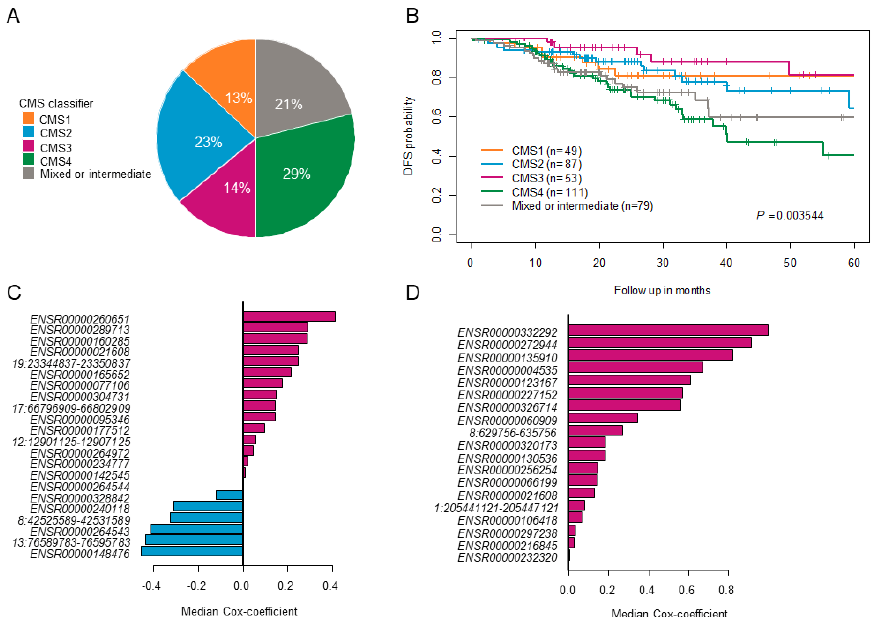
Figure 2. Identification of clinically relevant enhancer RNAs. ( A ) Pie-chart shows the percentage of colon cancer patients classified into various consensus molecular subtypes (CMS). ( B ) Kaplan–Meier plot shows survival estimates of disease-free survival in colon cancer patients stratified based on the CMS classification. ( C , D ) The bar graph shows prognostic eRNAs from the successful trials that significantly separated samples into two risk groups in the testing set and are ordered by their median cox-coefficient for disease-free survival. Positive scores are associated with shorter survival, and negative scores are associated with longer survival—22 prognostic eRNAs in colon cancer CMS4 subtype and 19 prognostic eRNAs in rectal cancer. ERNAs = enhancer